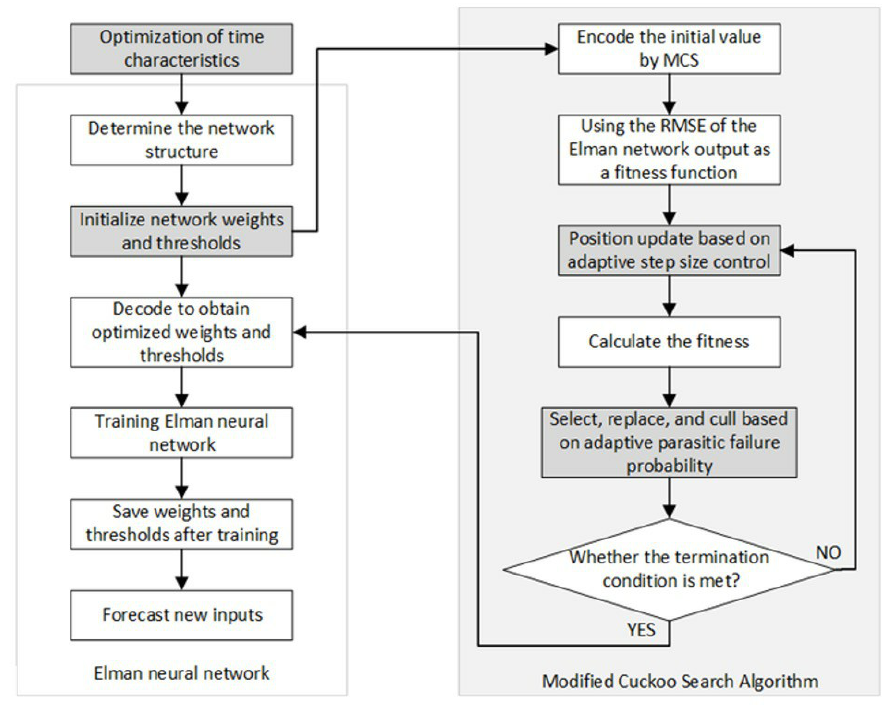
Figure 4. The forecasting process of TMCS-ENN